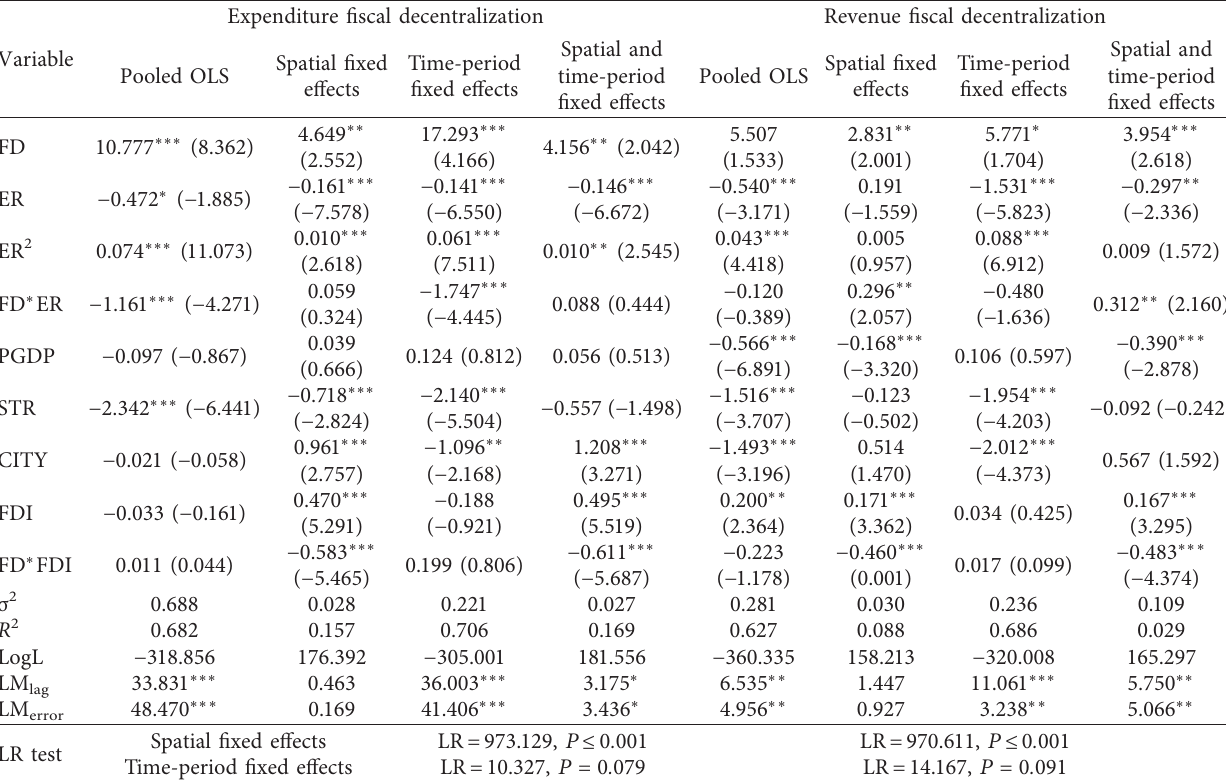
Figure 1: Moran scatter plot for environmental pollution in (a) 2003 and (b) Table 4: Estimation results of panel data models without spatial interaction effects.